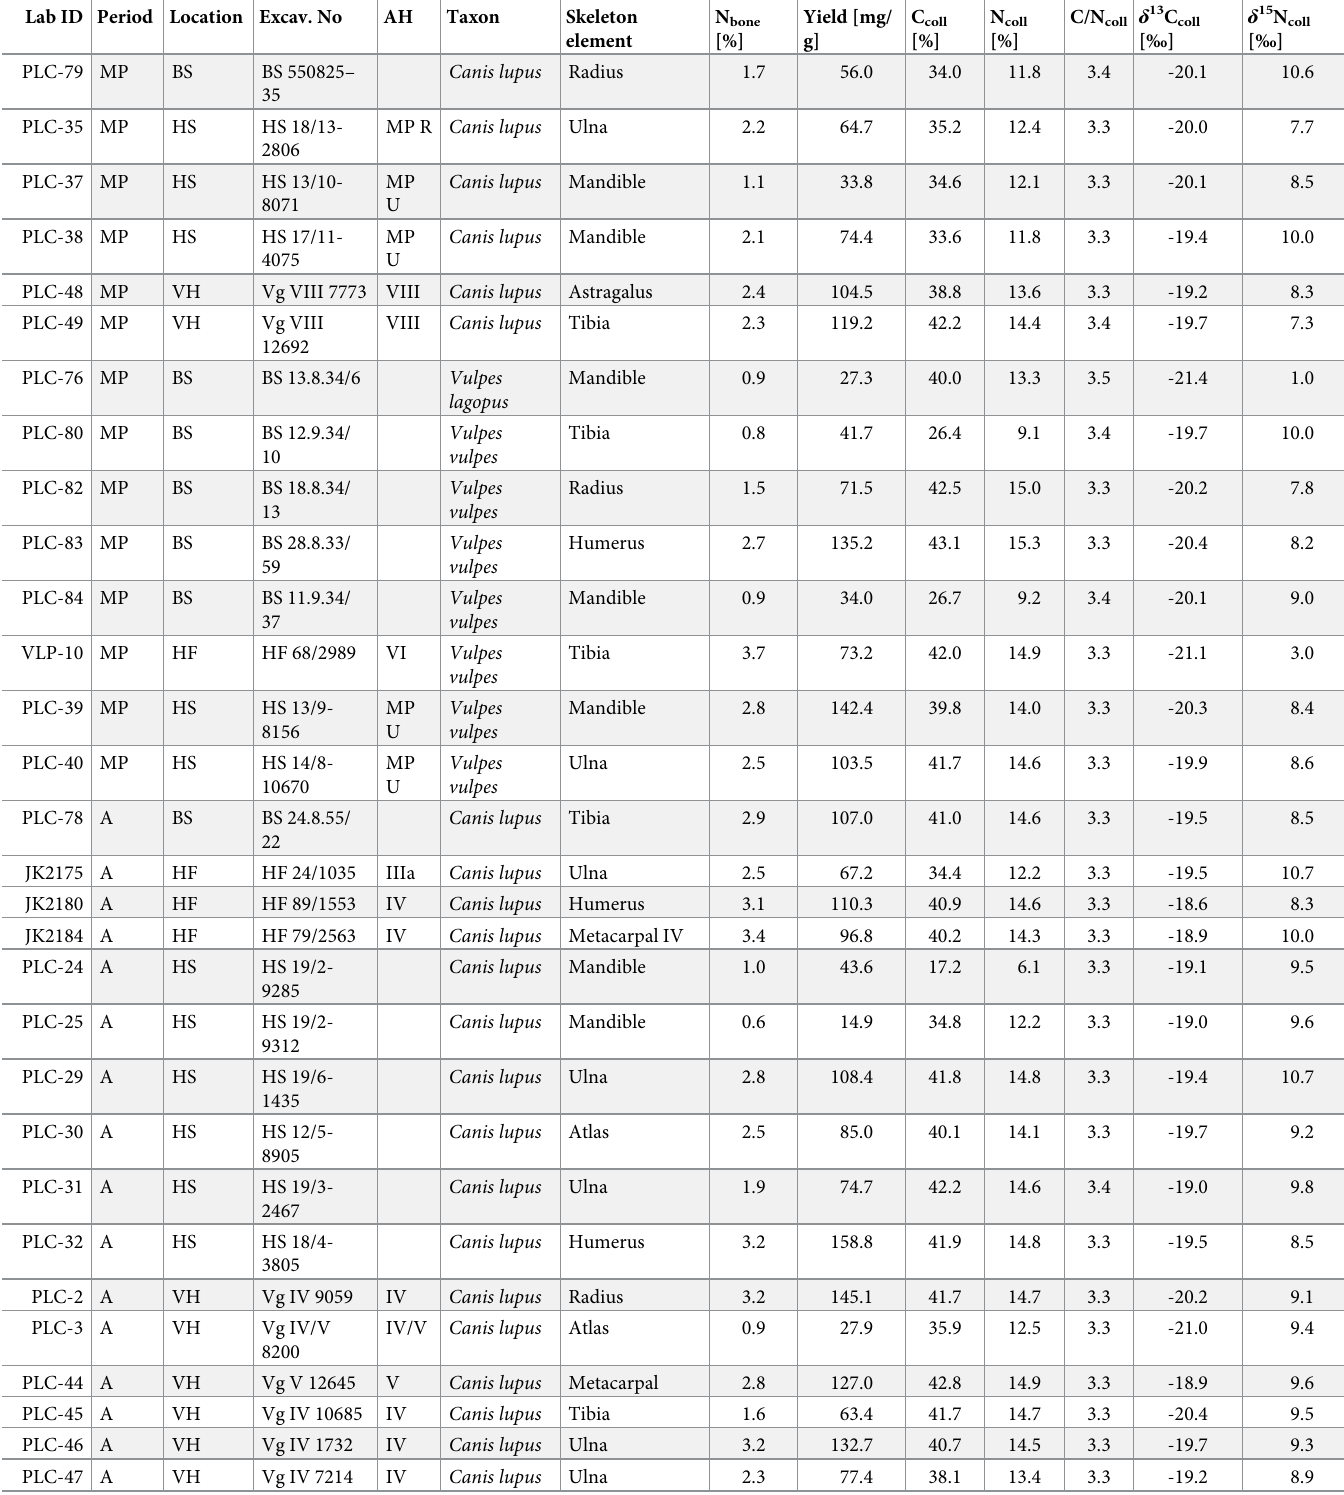
Table 1. List of newly analyzed isotopic values of carnivores reported in this study. Lab ID Period Location Excav.